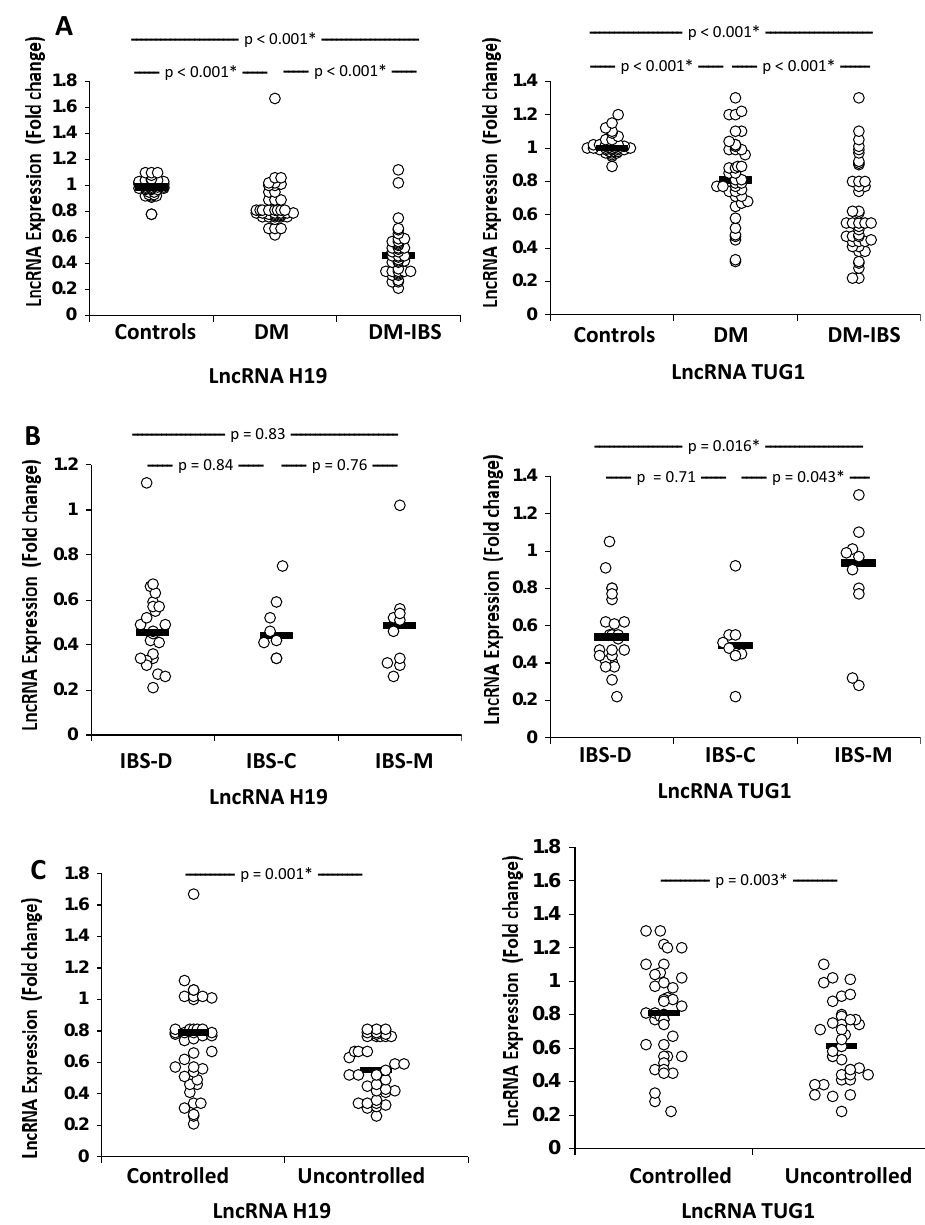
Figure 1. Dot plot of H19 and TUG1 expression in ( A ) healthy controls and different patient groups; ( B ) according to IBS type; ( C ) according to diabetes control measured by HbA1C. The horizontal bars show the medians. A and B: Kruskal –Wallis test followed by Dunn’s multiple comparisons test were used for statistical analysis. C: Mann – Whitney U test was used for statistical analysis. * Significant.